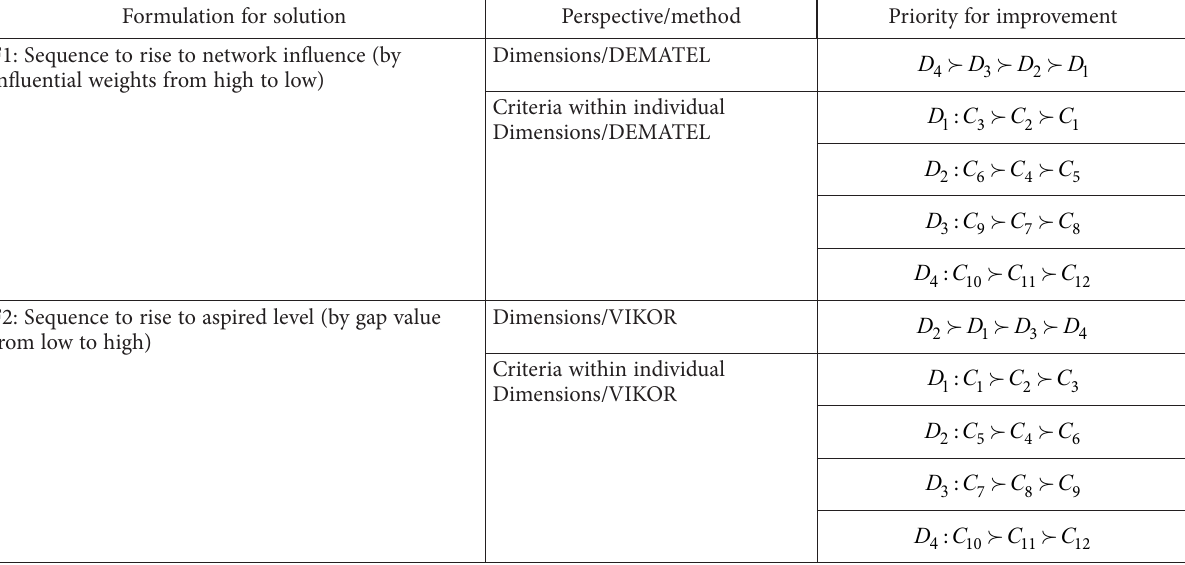
Table 6. Innovative action plan for hotel appraisal